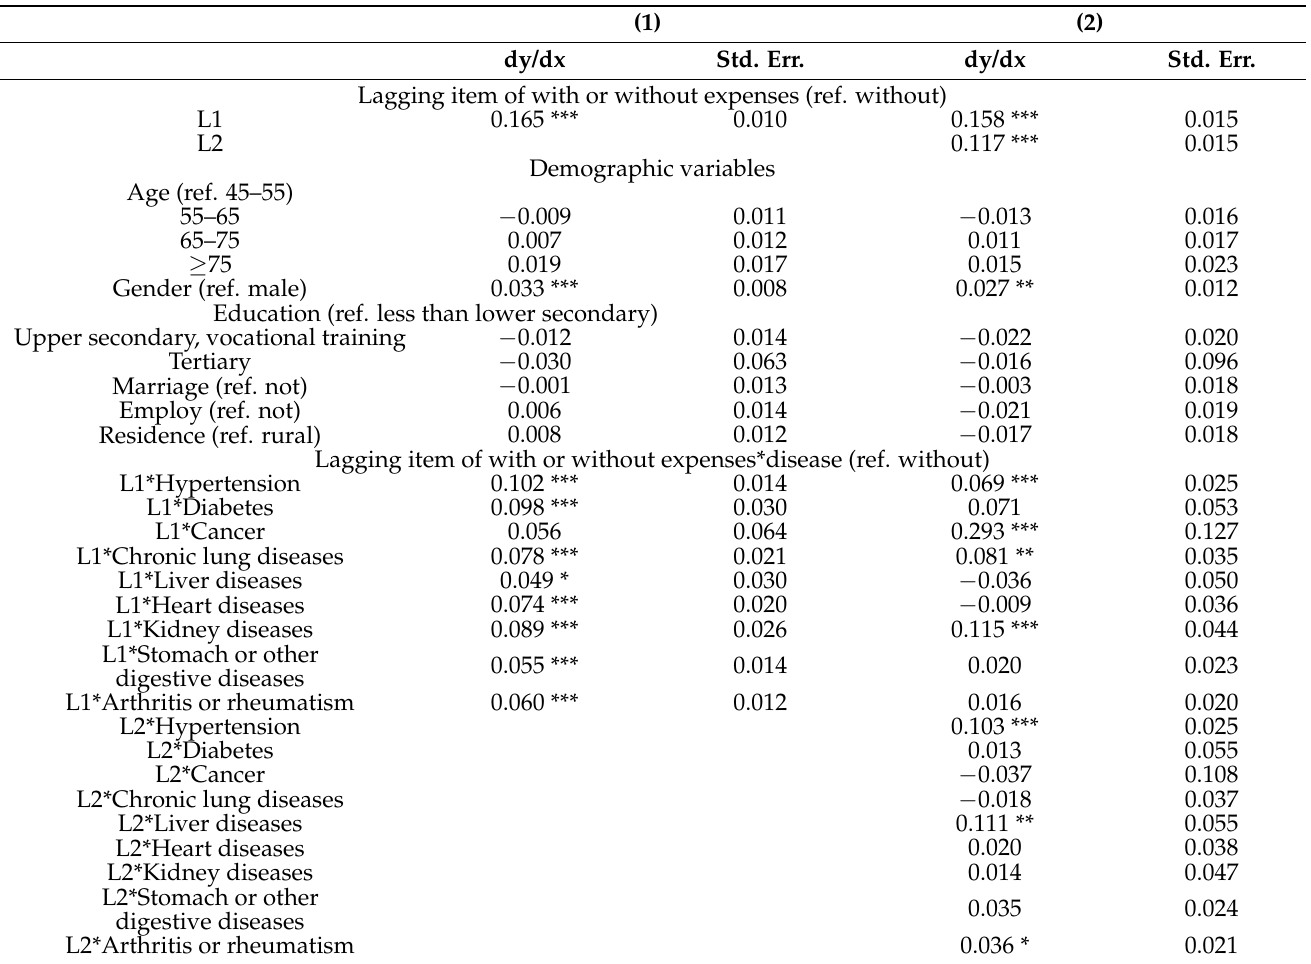
Table 5. Heckman probit coefficients: Regression on incidence of medical